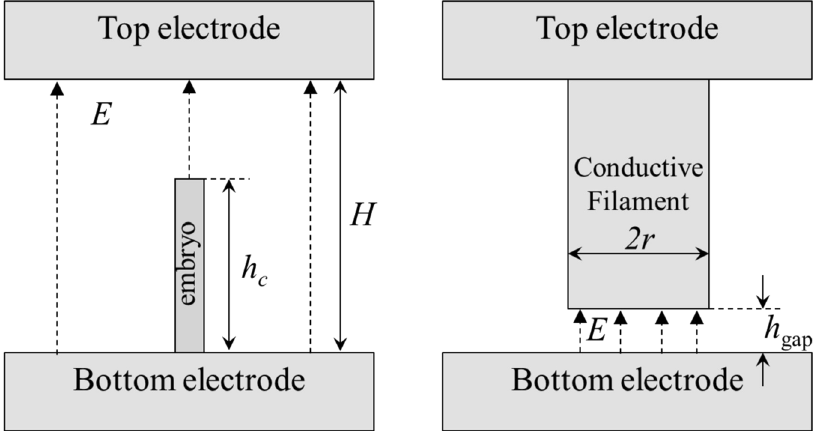
Figure 1. Left: critical length ( h c ) conductive embryo formed in a uniform electric field within a gap of height H significantly exceeding h c . That condition corresponding to that of the standard FIN theory can relate to a pristine (before ‘forming’) device structure. Right: a conductive filament with an insulating gap of thickness h gap in a ‘formed’ device. A small conductive embryo will nucleate inside the gap of h gap < h c , i. e. beyond the limits of applicability of the standard FIN. Dashed arrows represent the electric